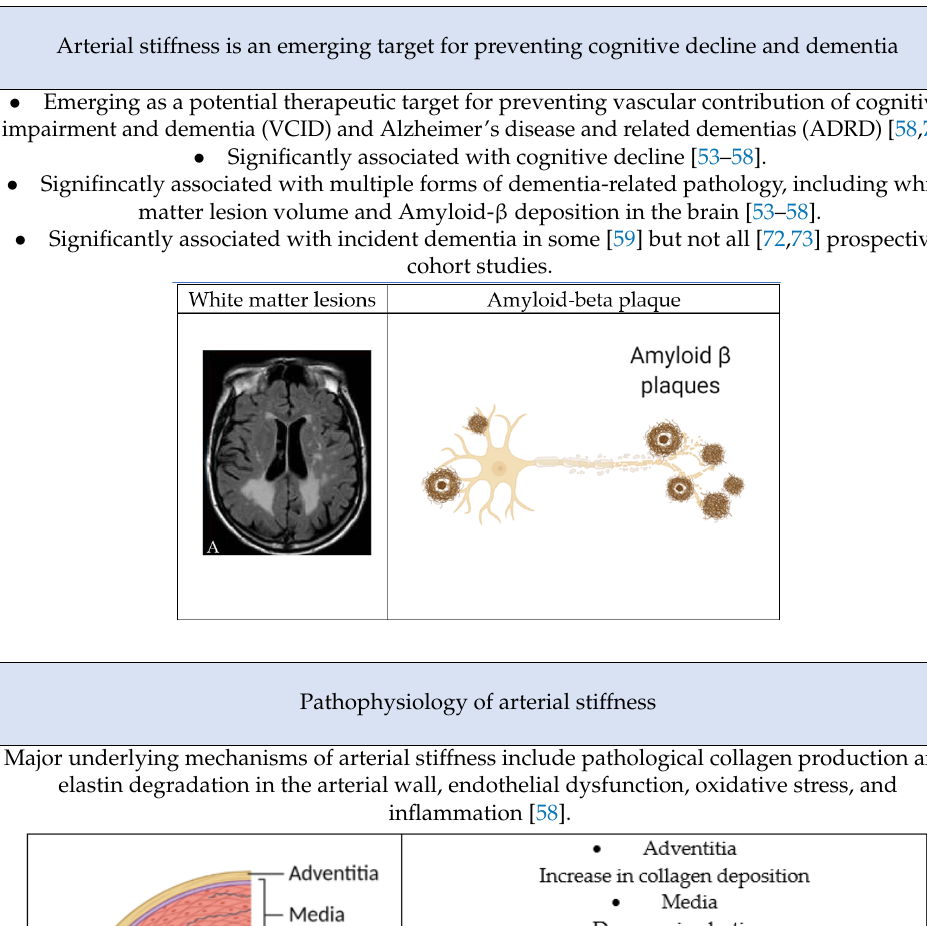
Table 1. Potential mechanisms of S ‐ equol to slow the progression of arterial stiffness (image of the white matter lesion is from Wikimedia Commons; images of amyloid β plaques and a cross ‐ sectional view of the aorta were created with BioRender).